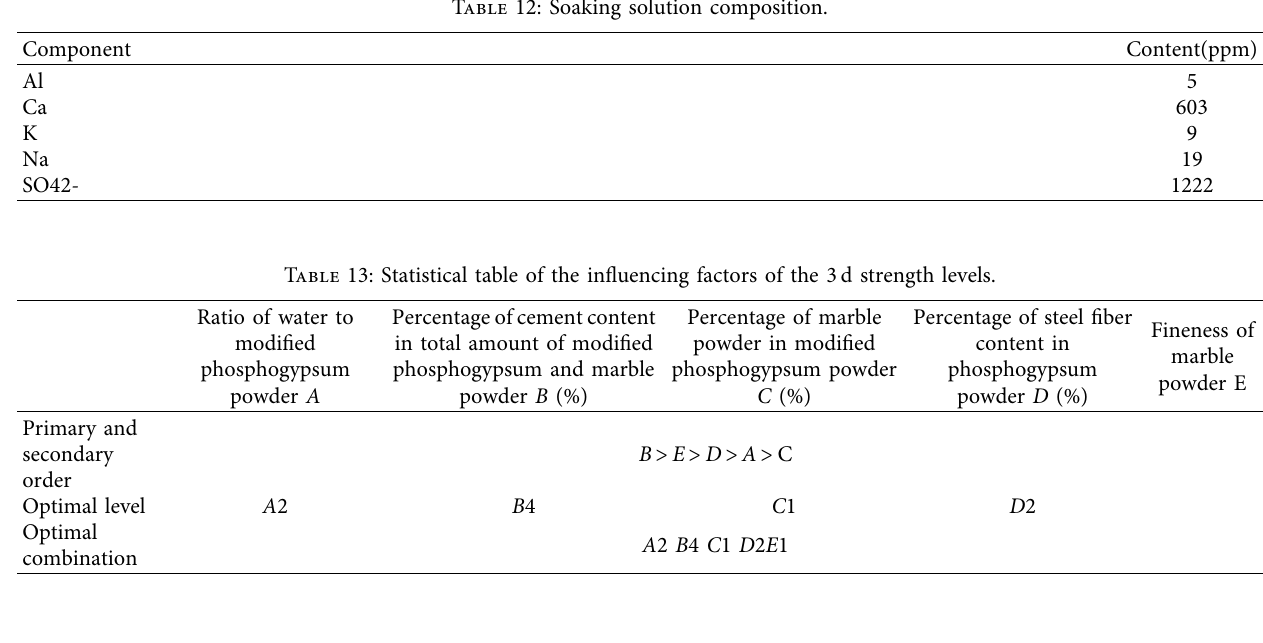
Table 14: Statistical table of the influencing factors of the 7d strength levels.